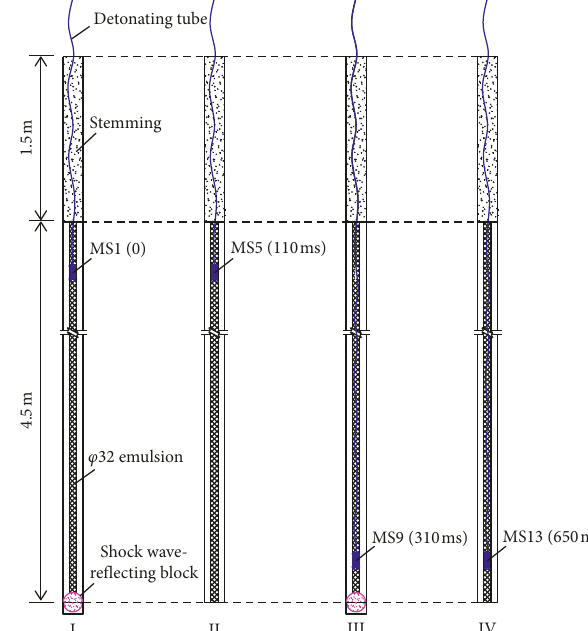
Figure 18: Charging structures in the single-hole blasting experiment.